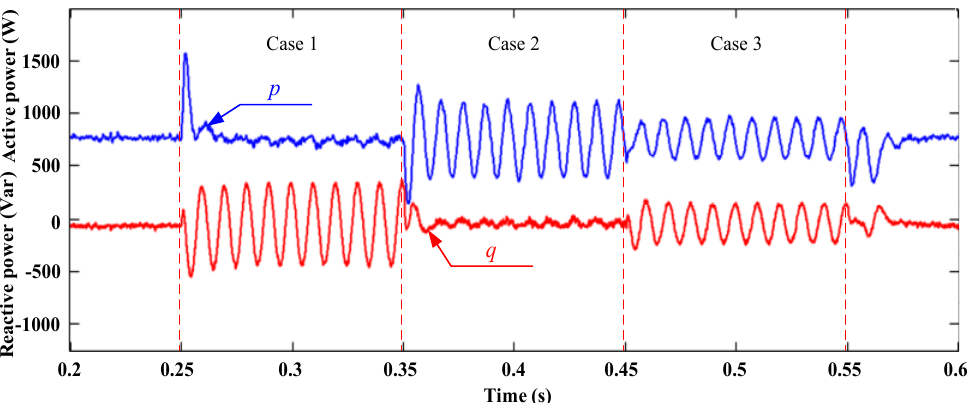
Figure 8. Simulated results of the active power and reactive power under the unbalanced grid voltage condition in three cases.